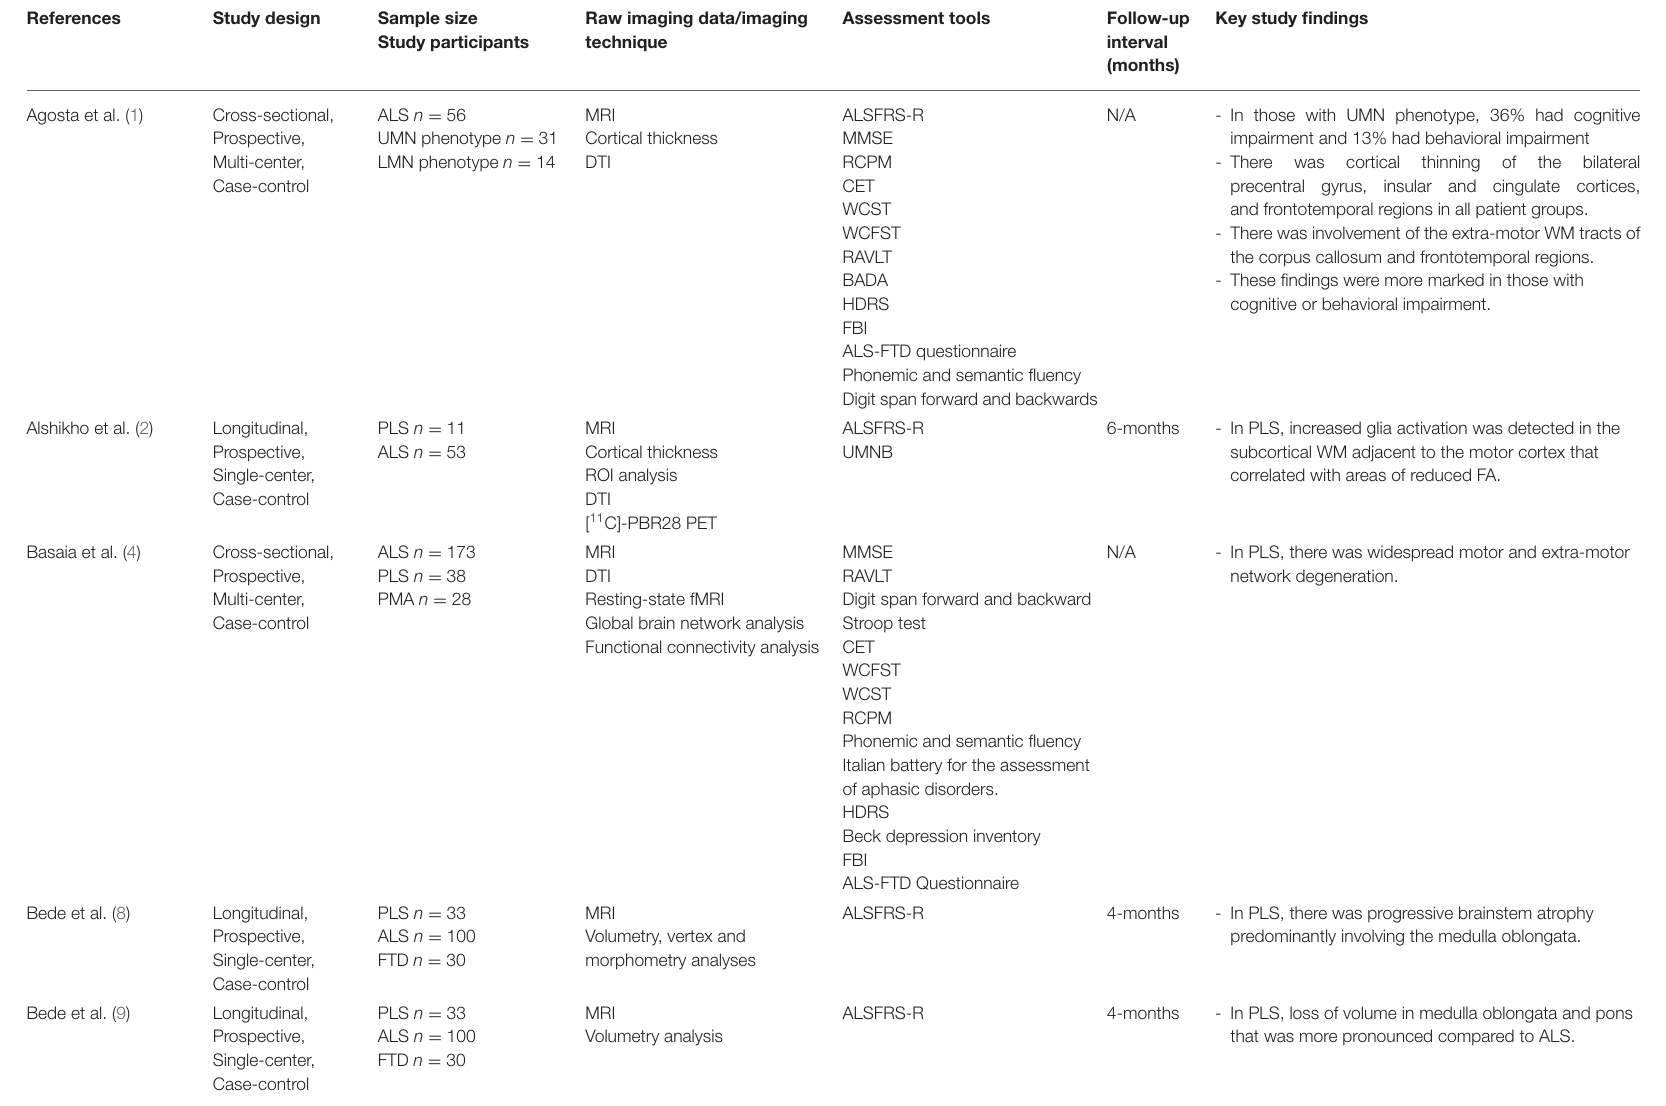
TABLE 2 | Selection of original neuroimaging research articles in